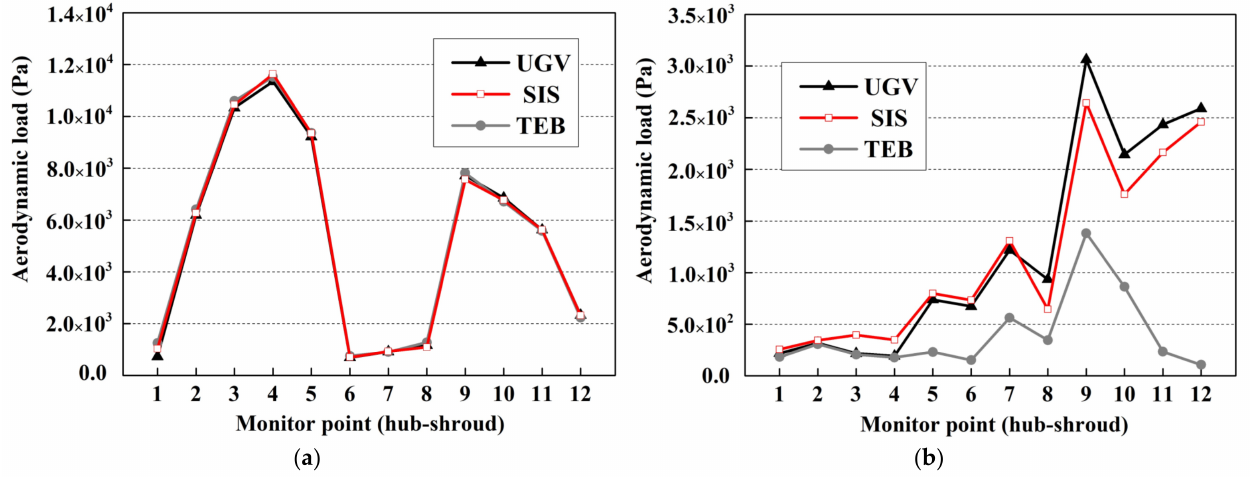
Figure 14. The aerodynamic load distribution from hub to shroud at the leading edge, including the comparison of ( a ) the amplitude at f m and ( b ) the amplitude at f i in different radial inlet